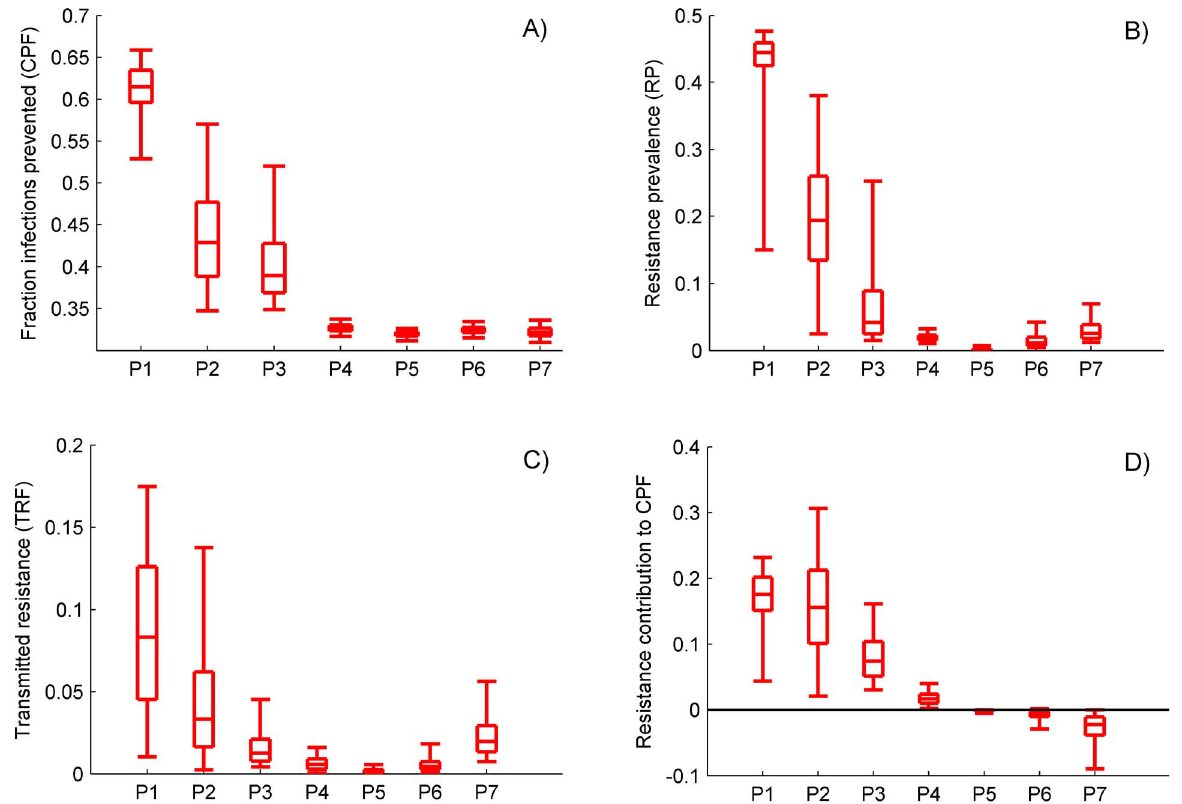
Figure 2. Public-health impact of 10 years of consistent PrEP use by 50% of the population projected by the model parameterized with the assumptions extracted from published papers. The outcomes presented are A) the cumulative fraction of prevented infections (CPF); B) resistance prevalence due to PrEP (RP); C) cumulative fraction of infections in which resistance is transmitted (TRF) and D) resistance contribution to CPF. The boxplots (median, 2.5th, 25th, 75th, 97.5th percentiles) reflect the variation in impact estimates based on 10,000 simulations (10 per preselected epidemic set). In D, the contribution of resistance to CPF is calculated as the percentage change in CPF from simulations in which the resistance is disregarded. Intervention parameters are fixed on their baseline values from Table 1, part